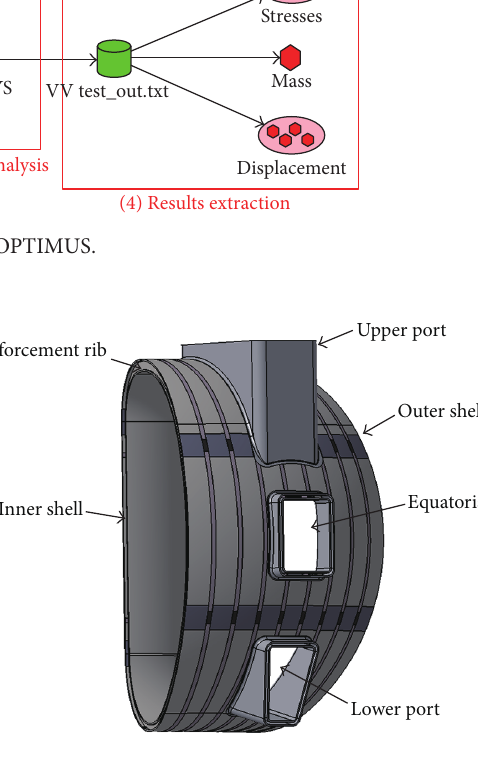
Figure 4: VV CAD model of